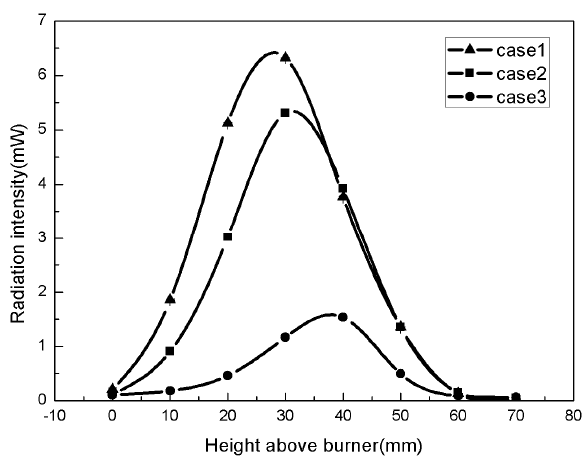
Figure 6. Radiation intensity at the centerline of three different flames.